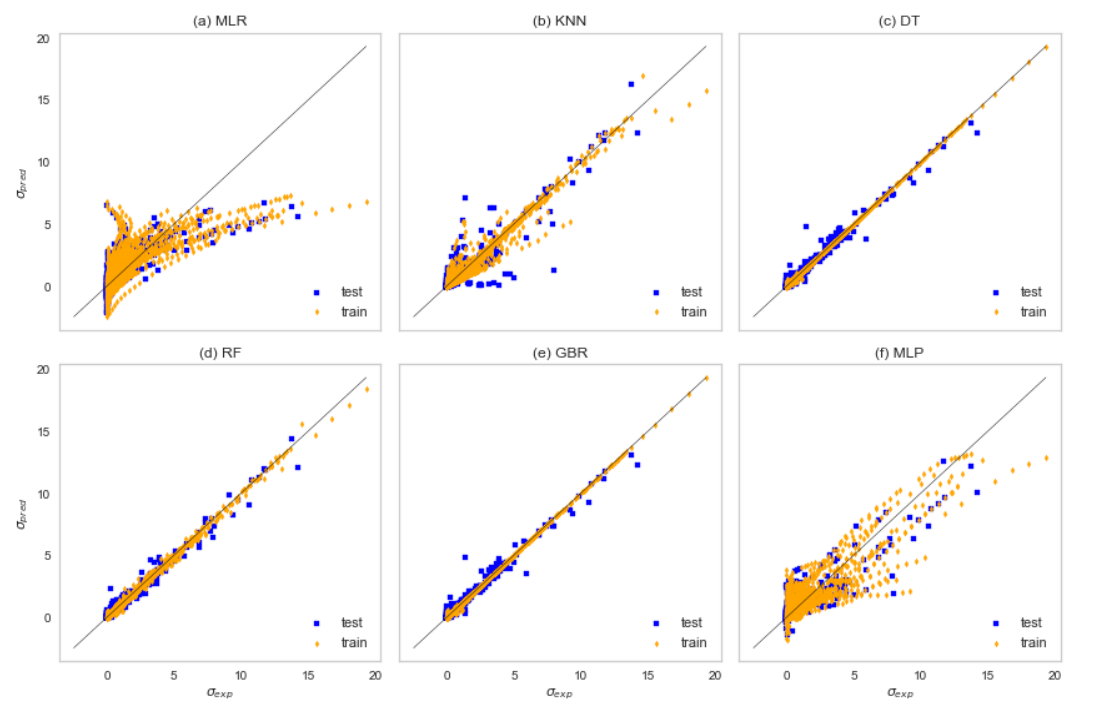
Figure 6. Experimental vs. predicted values for electrical conductivity with six different ML algorithms : ( a ) MLR; ( b ) KNN; ( c ) DT; ( d ) RI ( e ) GBR; ( f ) MLP. The 45 o straight line denotes perfect match.